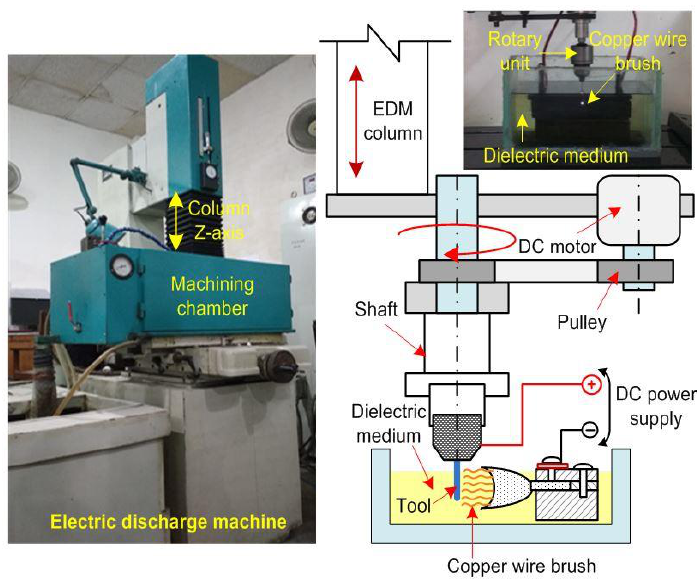
Figure 3. Pictorial view of the EDM machine and schematic view of the tool roughing system. A digital weighing machine (Shimadzu AUW220D, Kyoto, Japan) was used to meas- ure the initial and final weight of work material. The L and D are the hole depth and diameter, respectively, wherein the subscripts ST and TT represents the smooth/conven- tional tool and rough tool electrode, respectively. A stereo zoom microscope (Make: Ni- kon SMZ745T, Nanyang, China) was used to measure the depth and diameter of the ma- chined holes. 3. Results and Discussion